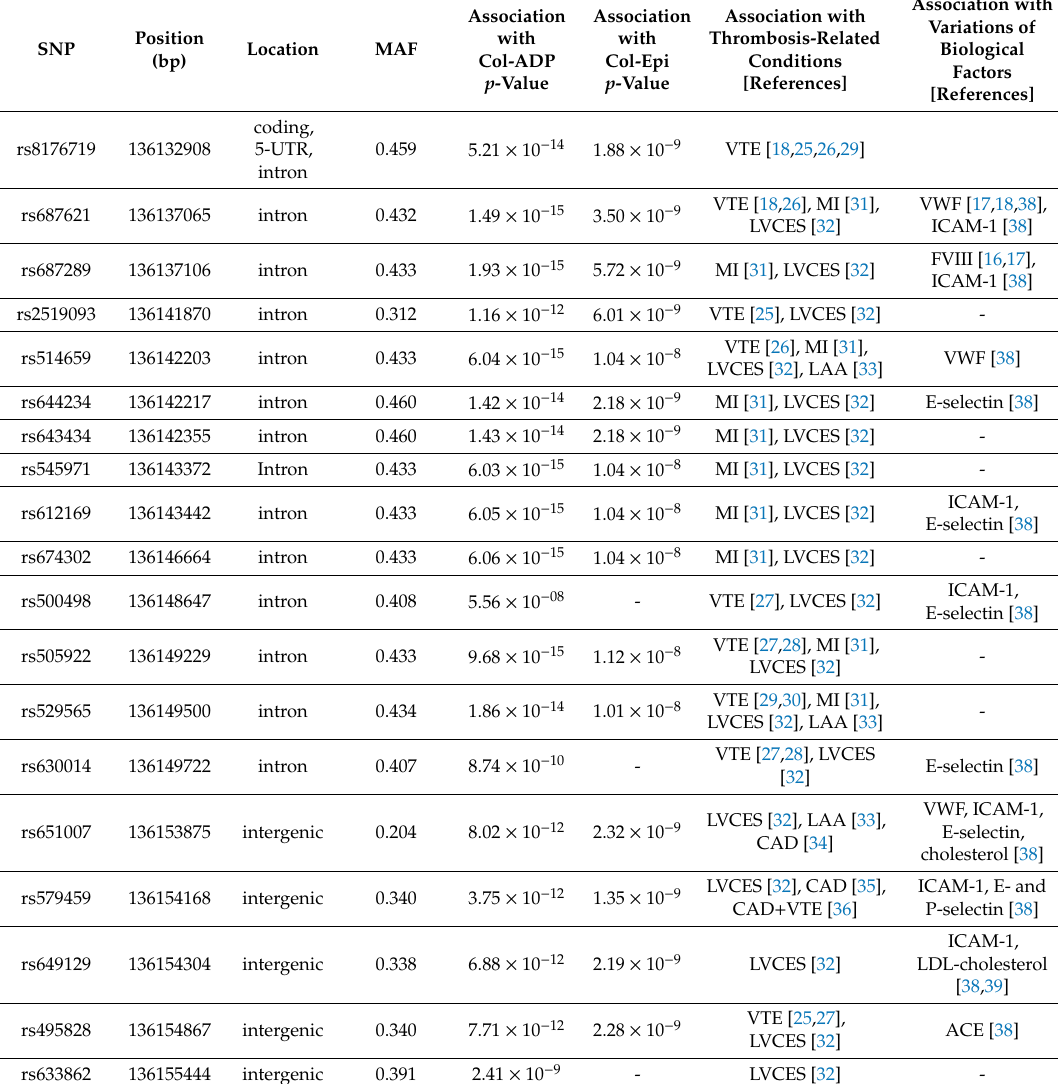
Table 2. ABO locus (chromosome 9): SNPs associated with PFA-100 phenotypes which have been previously described in association with thrombosis-related conditions and with variations of biological